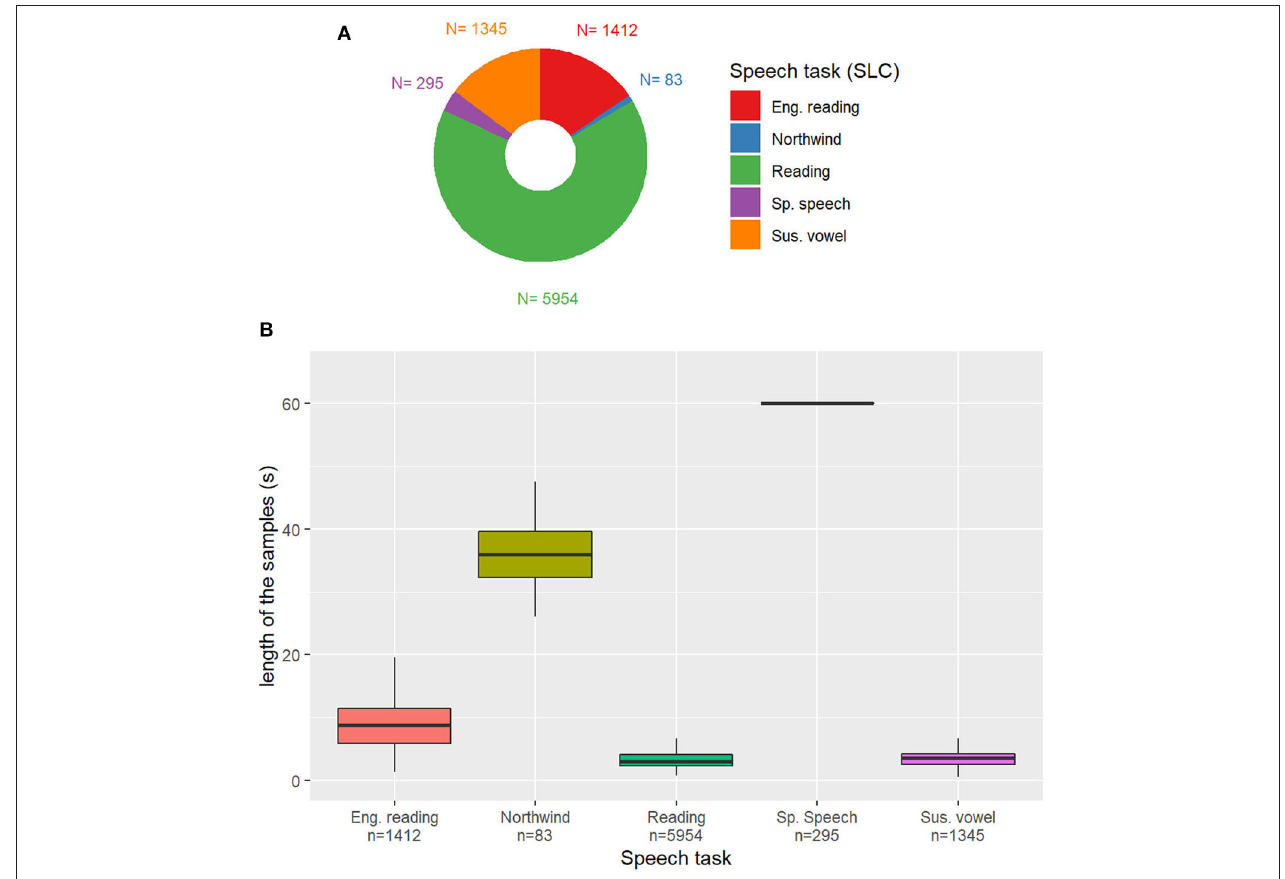
FIGURE 2 | (A) Distribution of the speech tasks in the Sleepy Language Corpus (SLC). Eng. Reading : reading of simulated pilot-air traffic controller communication statements in English; Northwind : German version of the story “the North Wind and the Sun”; Reading : simulated driver assistance system commands/requests; Sp. Speech : self-presentation (spontaneous speech); Sus. vowel : sustained vowel. n: Number of samples in the category. (B) Duration of the samples depending on the task. Outliers removed for readability.